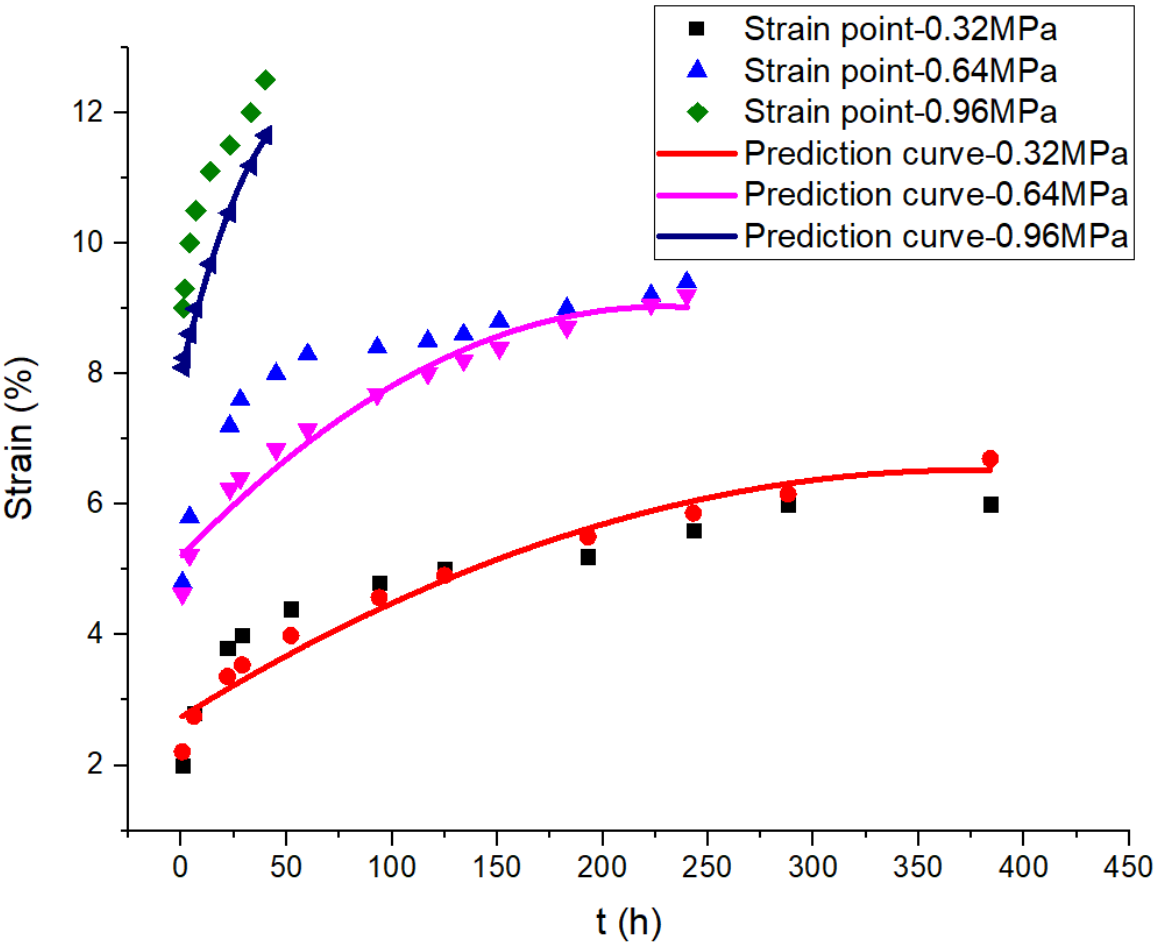
Figure 7. Comparison of strain points and predicted curves of creep in the HT environment.